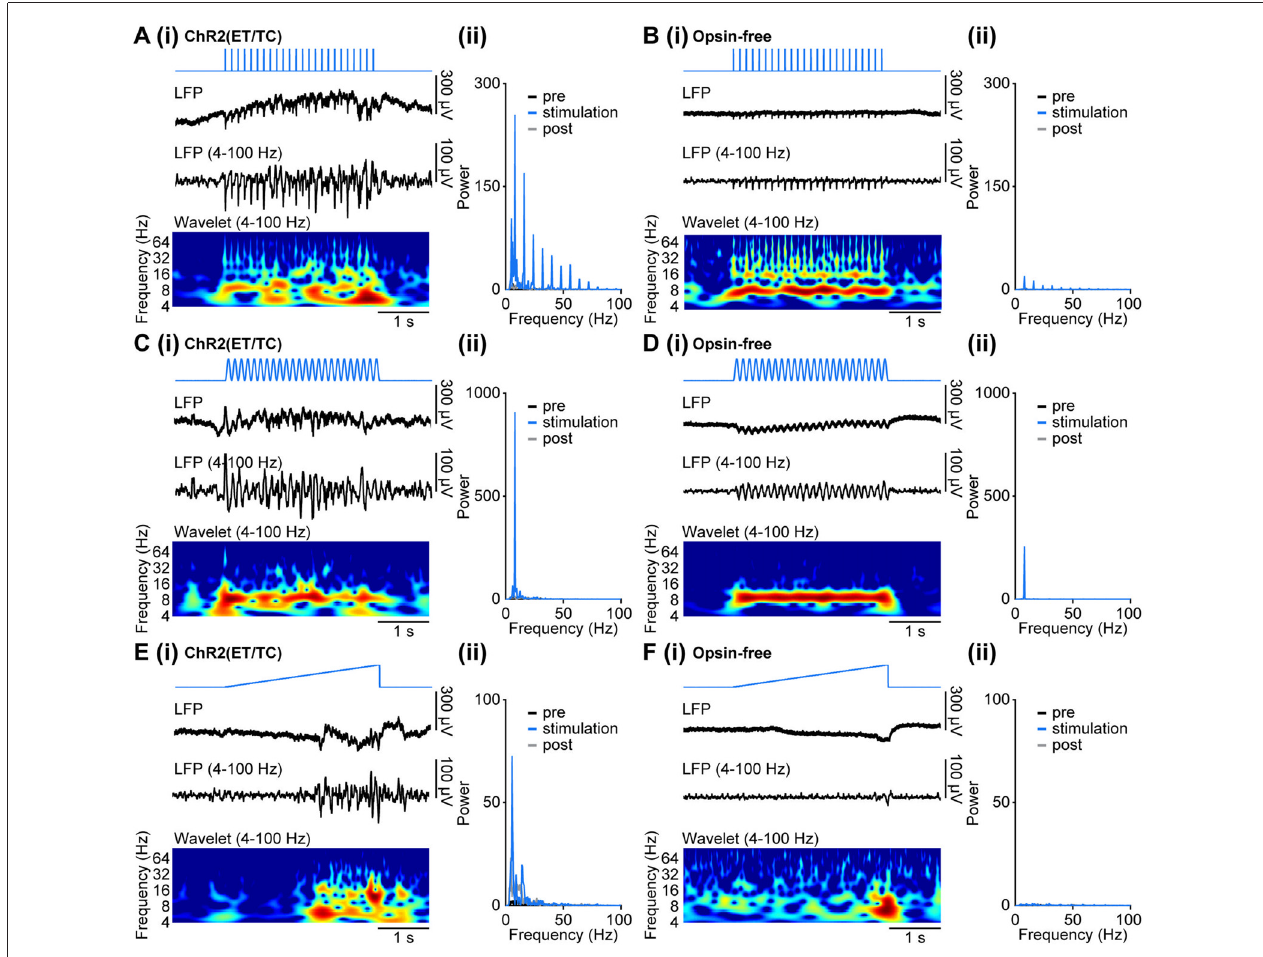
FIGURE 5 | Generation of coordinated network activity in the neonatal PFC as result of different patterns of light stimulation in vivo . (Ai) Discontinuous oscillatory activity displayed together with the corresponding color-coded wavelet spectrum at identical time scale recorded in response to repetitive light pulses (473 nm, 3 ms, 14 mW/mm 2 ) at 8 Hz from a P10 mouse with layer II/III pyramidal neurons transfected by IUE at E15.5 with ChR2(ET/TC). (ii) Plots displaying the corresponding power spectrum for 3 s before light stimulation (pre, black), 3 s during ramp stimulation (stimulation, blue), and 3 s after light stimulation (post, gray). (Bi,ii) Same as (Ai,ii) for a P10 mouse transfected by the same procedure with an opsin-free construct. (Ci,ii,Di,ii) Same as (Ai,ii,Bi,ii) for sinusoidal light stimulation. (Ei,ii,Fi,ii) Same as (Ai,ii,Bi,ii) for ramp light stimulation.